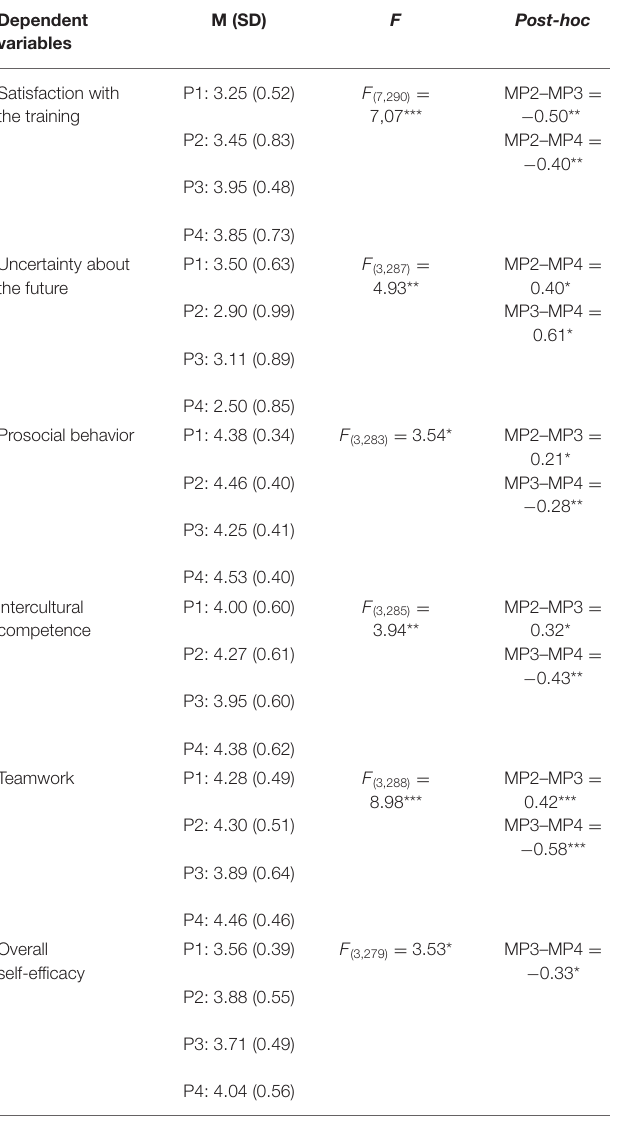
TABLE 5 | One-way ANOVA of the learning variables according to the variable “participants in the reflection.” F Post-hoc Dependent variables